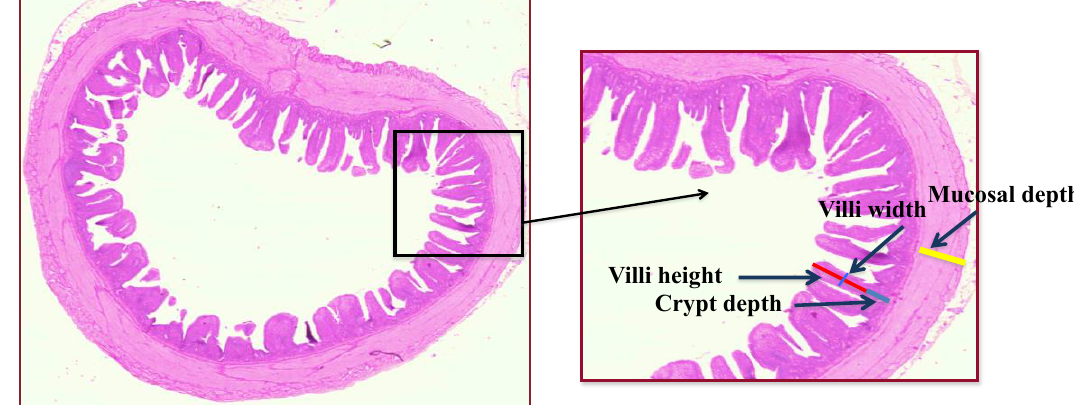
Figure 1. Histo-morphological parameters, including villi height, villi width, mucosal depth and crypt depth, for a histology section (0.5 μm thick, stained using haematoxylin and eosin staining using the procedure of Drury and Wallington (1980) and the Tissue- Tek® DRS™ (Sakura Finetek USA Inc., Torrance CA)) prepared at the ileocaecal junction region of the gastrointestinal tract (GIT) in a laying hen (Lohmann Brown Classic, 67 weeks) (Original figure by G.K.).